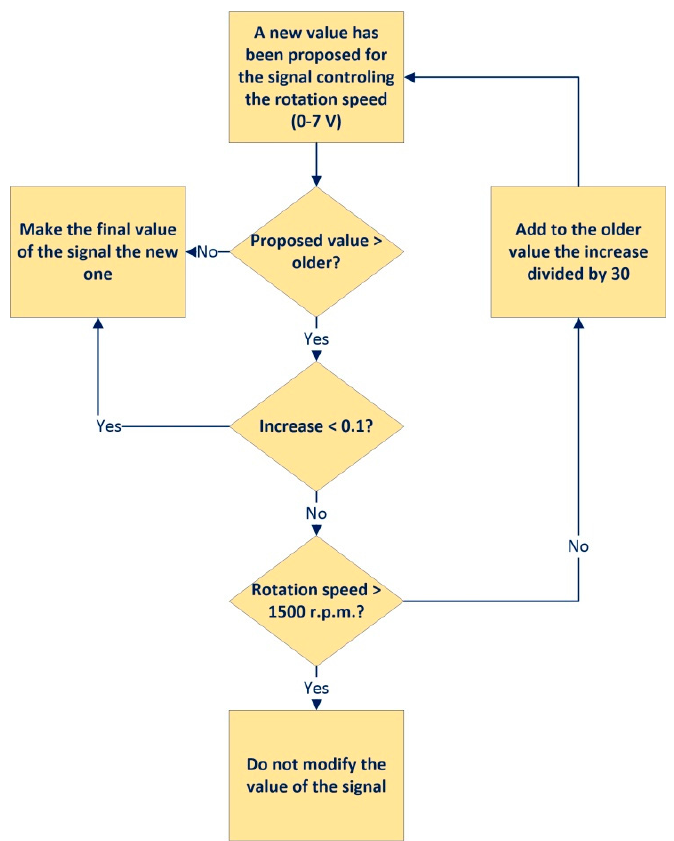
Figure 13. Safety algorithm for the DC engine.